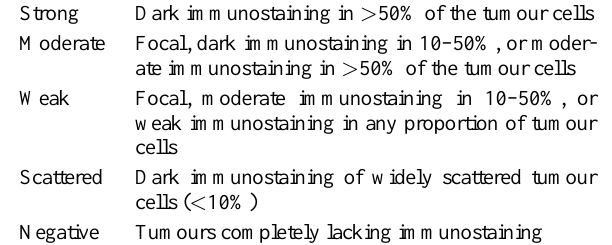
Evaluation of p53, ER, PR